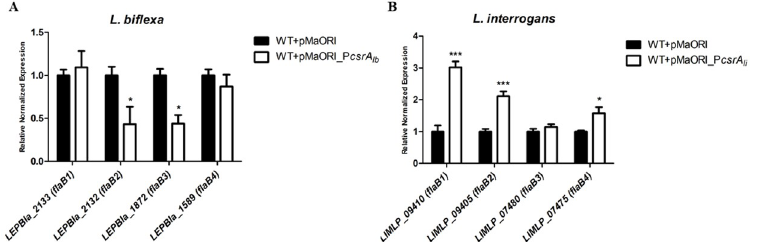
Fig 8. Effect of overexpressed CsrA on flaB expression. Expression of 4 flaB genes in Leptospira strains by RT-qPCR. RNAs were prepared from 3 independent cultures of each leptospiral strain and used for RT-qPCR. Results are presented as relative fold changes ± SEM using cysK and lipL32 for normalization in L . biflexa and L . interrogans , respectively. ( � ), ( �� ) and ( ��� ) indicate p-value < 0.05, < 0.01 and < 0.001, respectively.